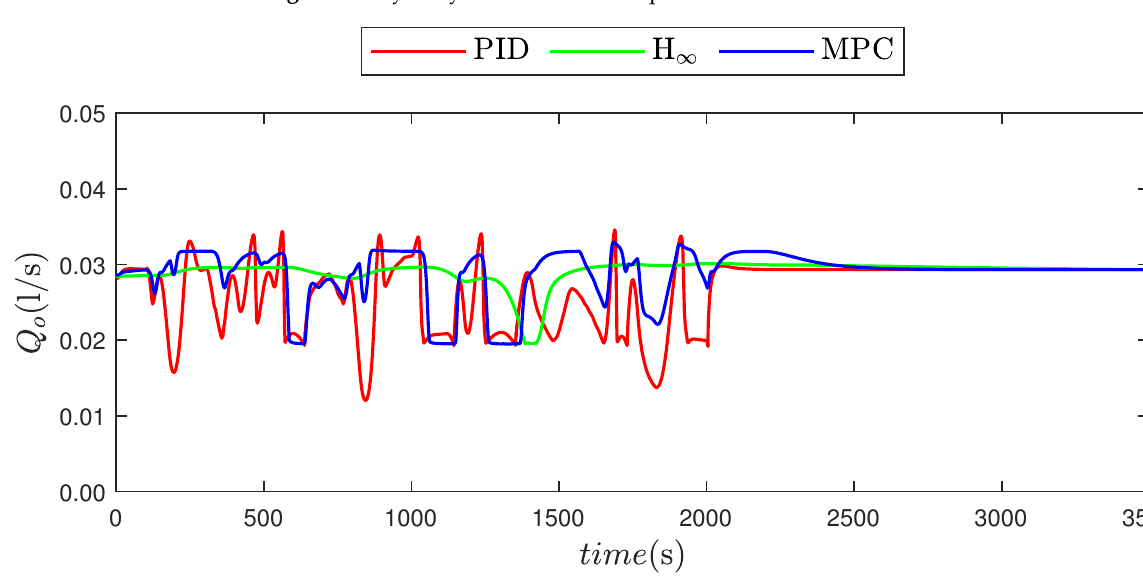
Figure 13. Hydrocyclone underflow liquid flow.